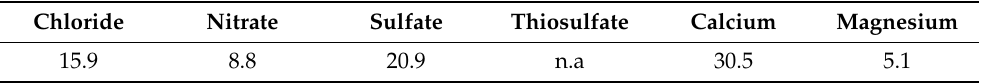
Table 3. Chemical composition (mg/L) of tap water used for flotation